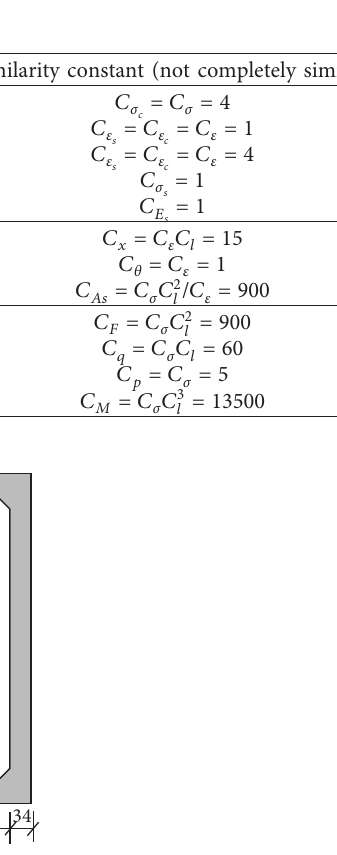
Figure 4: Model utility tunnel cross section